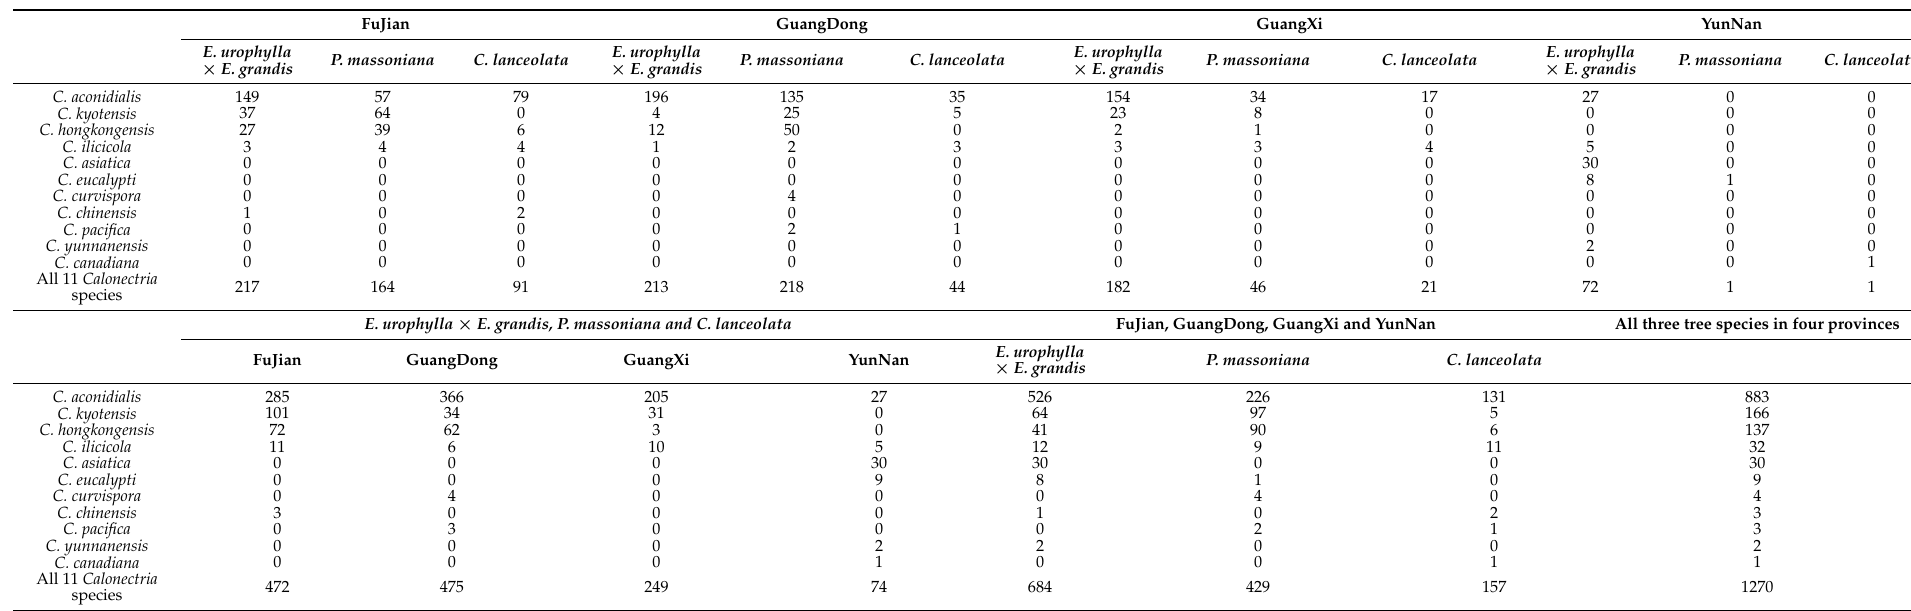
Table 6. Number of isolates of each Calonectria species obtained from plantations of three tree species in four provinces.